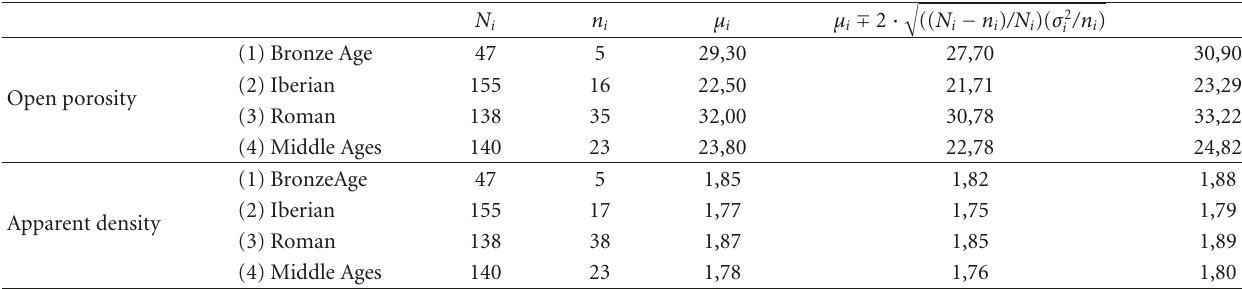
Table 5: Statistics of the stratified random sampling for open porosity and apparent